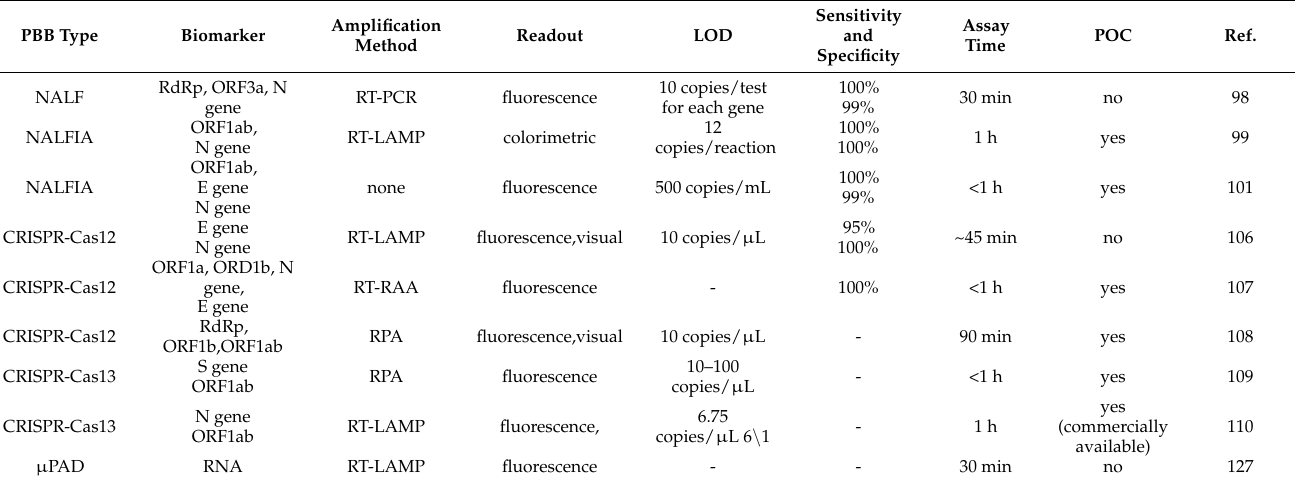
Table 1. Severe acute respiratory syndrome coronavirus 2 (SARS-CoV-2) gene detection methods. Abbreviations: RT-PCR = reverse transcription polymerase chain reaction; RT-LAMP = reverse transcription loop-mediated isothermal